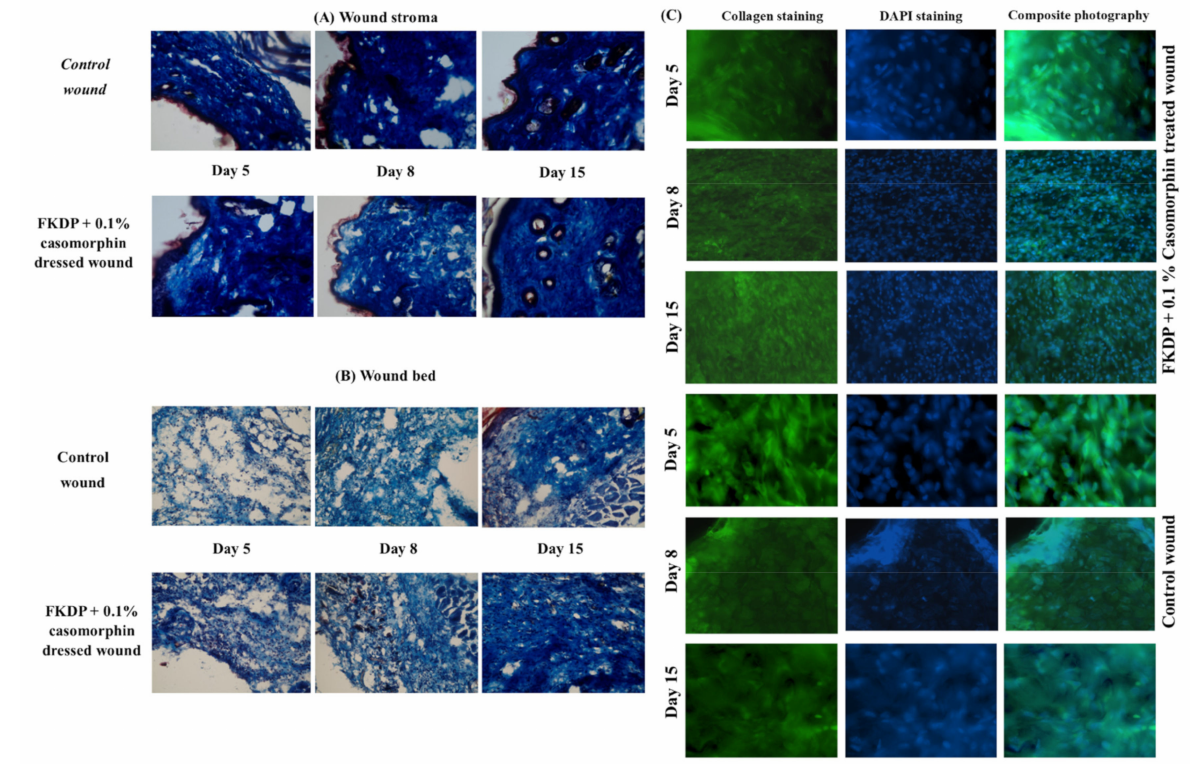
Figure 4. Masson Trichrome staining tissue derived from ( A ) wound stroma and ( B ) wound bed from control and FKDP + 0.1%Caso-treated wounds in 100 × magnification. ( C ) Tissue biopsy taken from FKDP + 0.1%Caso (3 upper panels) treated wound and control wound (lower panel) immunolabeled for collagen (green), nucleus (blue), (color online, black & white in